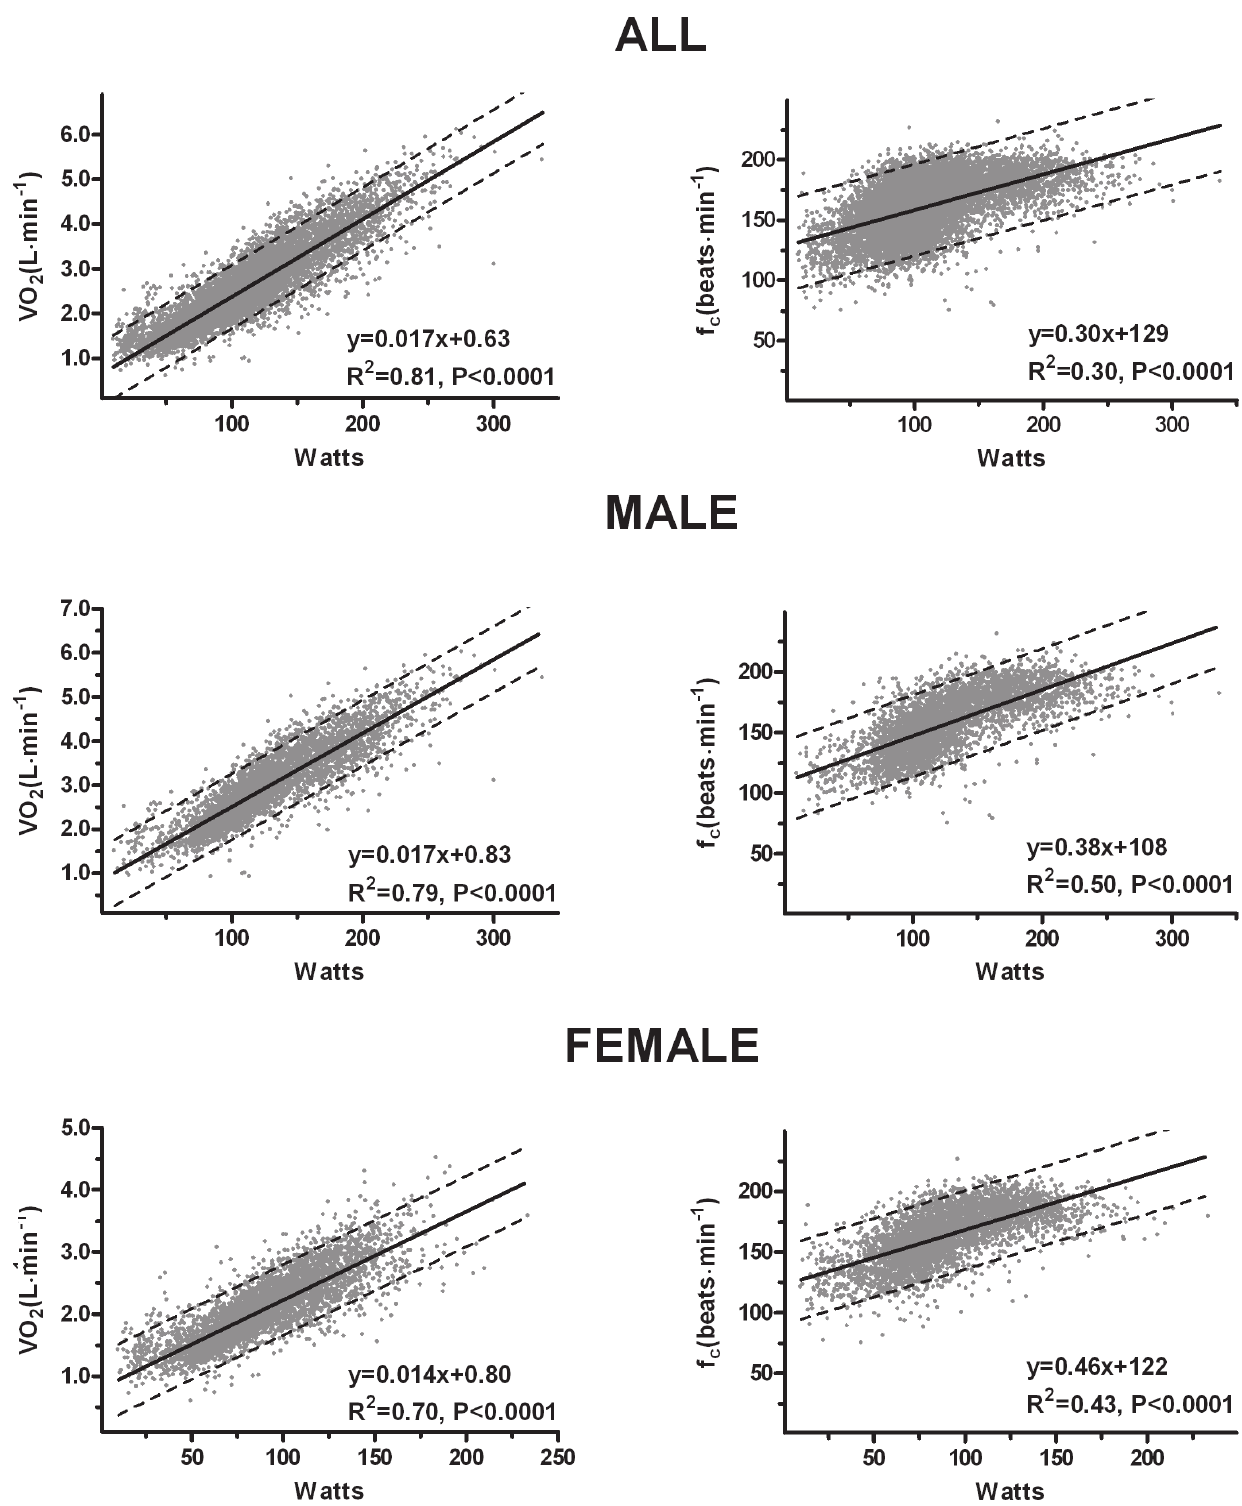
Figure 2. Correlations between workload (Watts) and oxygen uptake (VO 2 ) and correlations between Watts and heart rate (f c ).